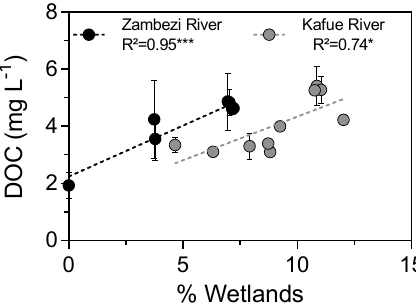
Figure 4. Relationships between DOC and % wetlands in the catch- ment in the Zambezi and the Kafue rivers during the wet periods, with ∗ p <0.1, and ∗∗∗ p <0.001. For the Zambezi, only the sam- ples collected in the upper part of the basin have been considered due to the effect of the Kariba and Cahora Bassa reservoirs on the longitudinal pattern of DOC